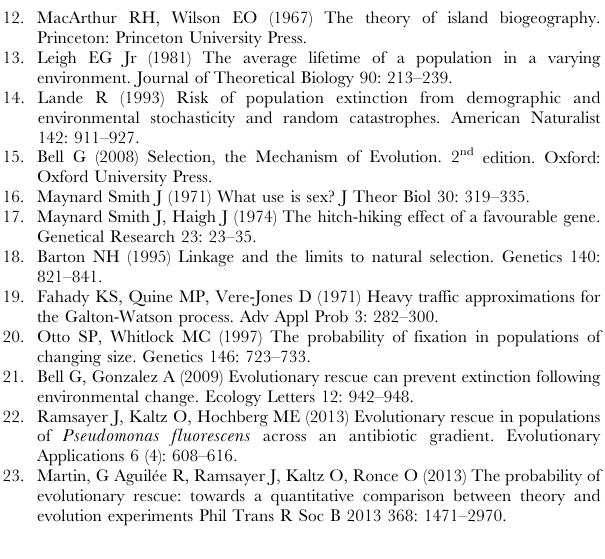
Figure S1 The distribution of waiting times until a new beneficial mutation arises that escapes stochastic loss and rescues the population. Gray bars represent the observed distribution from 10,000 successful realizations, blue line is the predicted approx- imate exponential distribution (Eq. 18), red line is the improved distribution (Eq. S2.3). A) N 0 =10,000, r = 0.01, s = 0.02, u = 10 2 5 B) N 0 =10,000, r =0.003, s =0.02, u = 10 2 5 . (PDF) Text S1 Derivation of analytical results for the U-shaped curve of evolutionary rescue when the number of starting mutants ( k ) is not small. (DOCX) Text S2 Derivation of the distribution of waiting times until a new mutation arises that eventually saves the